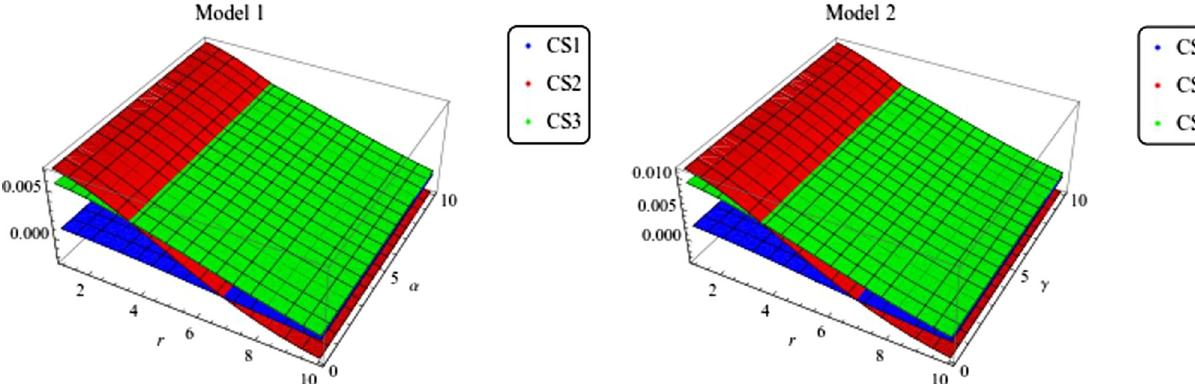
Fig. 2 Graph for the radial pressure (km − 2 ) evolution with both f ( R ) models